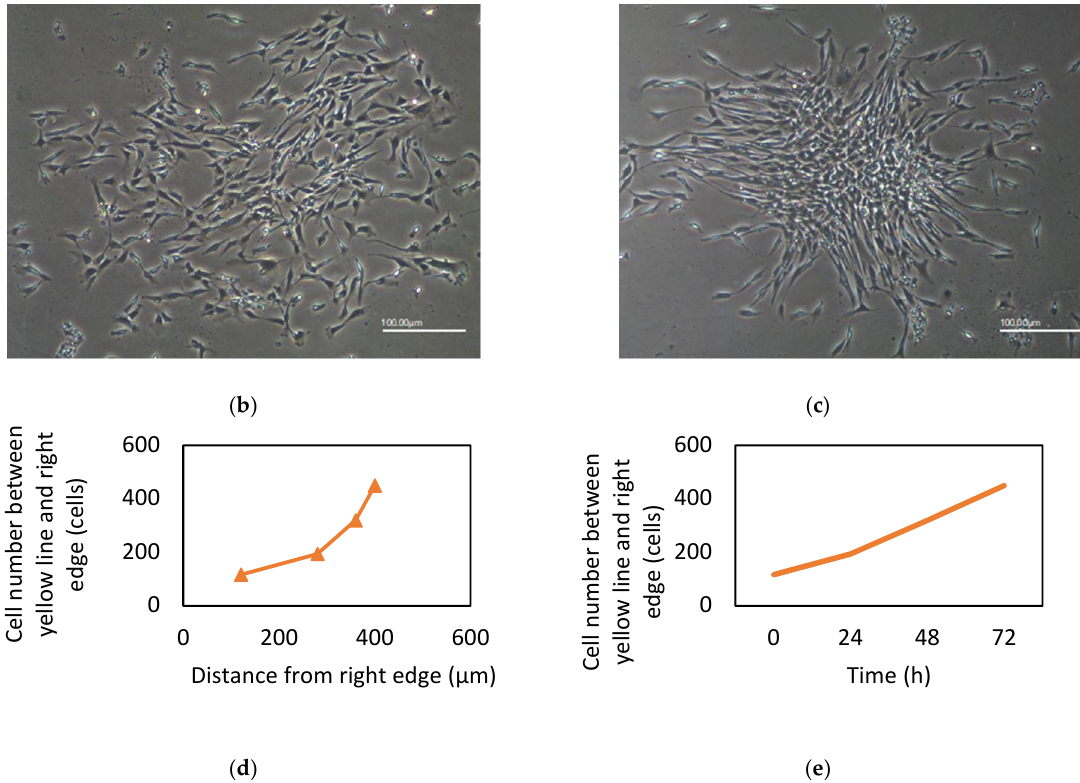
Figure 7. MSC recruitment tests and analysis. ( a ) Under 40× magnification, various time points of MSC patterns in the Gel/HA–HAP–SDF-1 group, Gel/HA–HAP group and control group are presented from left to right. The front line of the MSCs is indicated by a yellow line. These images reveal that MSCs gathered together and colonized in the control group and in the Gel/HA–HAP group. MSCs in the Gel/HA–HAP–SDF-1 group migrated left, along the concentration gradient of SDF-1 released from the composite. After 24 h, MSCs in the control ( b ) and Gel/HA–HAP ( c ) groups gathered together without migrating toward one direction under 100× magnification. ( d ) Cell number of MSCs between the yellow line and right edge versus distance from the right edge in the Gel/HA–HAP–SDF-1 group. ( e ) Cell number of MSCs between the yellow line and right edge versus time in the Gel/HA–HAP–SDF-1 group.